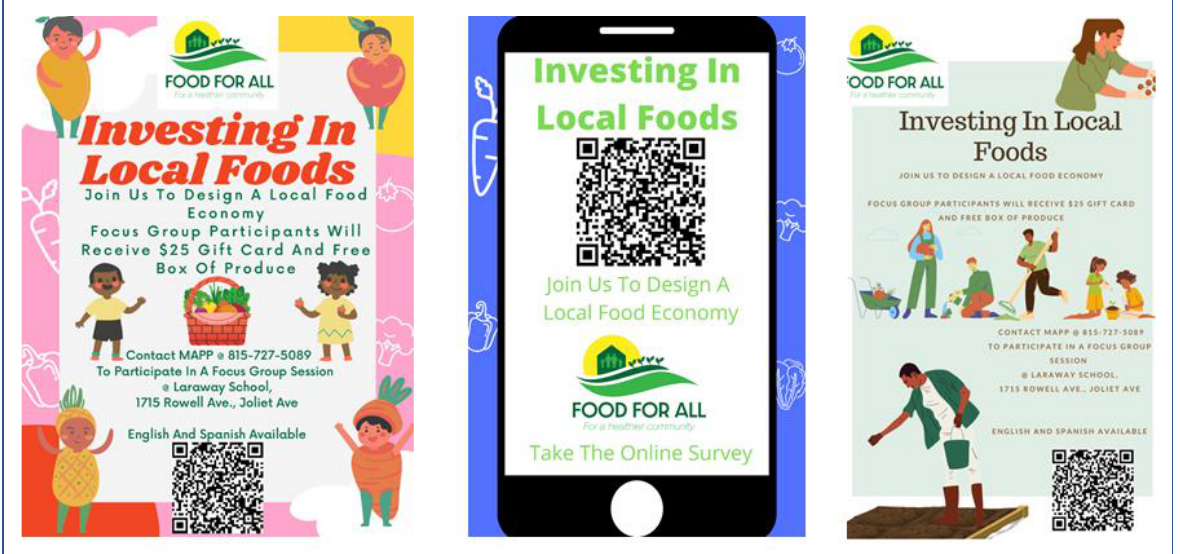
Figure 6. Food For All — Building Food Community Empowerment in Will